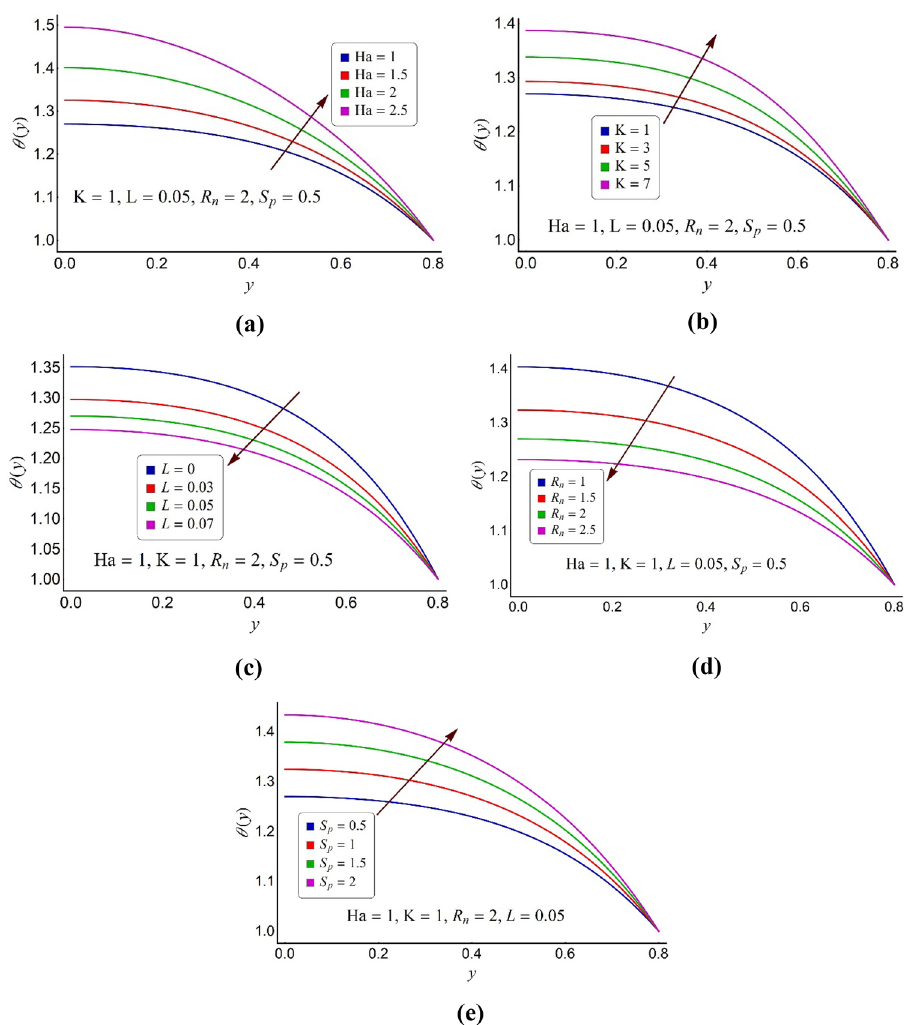
Figure 5. Alterations in temperature distribution of ternary fluid for various values of ( a ) Hartmann number Ha, ( b ) electroosmotic parameter K, ( c ) momentum slip parameter L , ( d ) thermal radiation number, ( e ) ohmic heating parameter S p